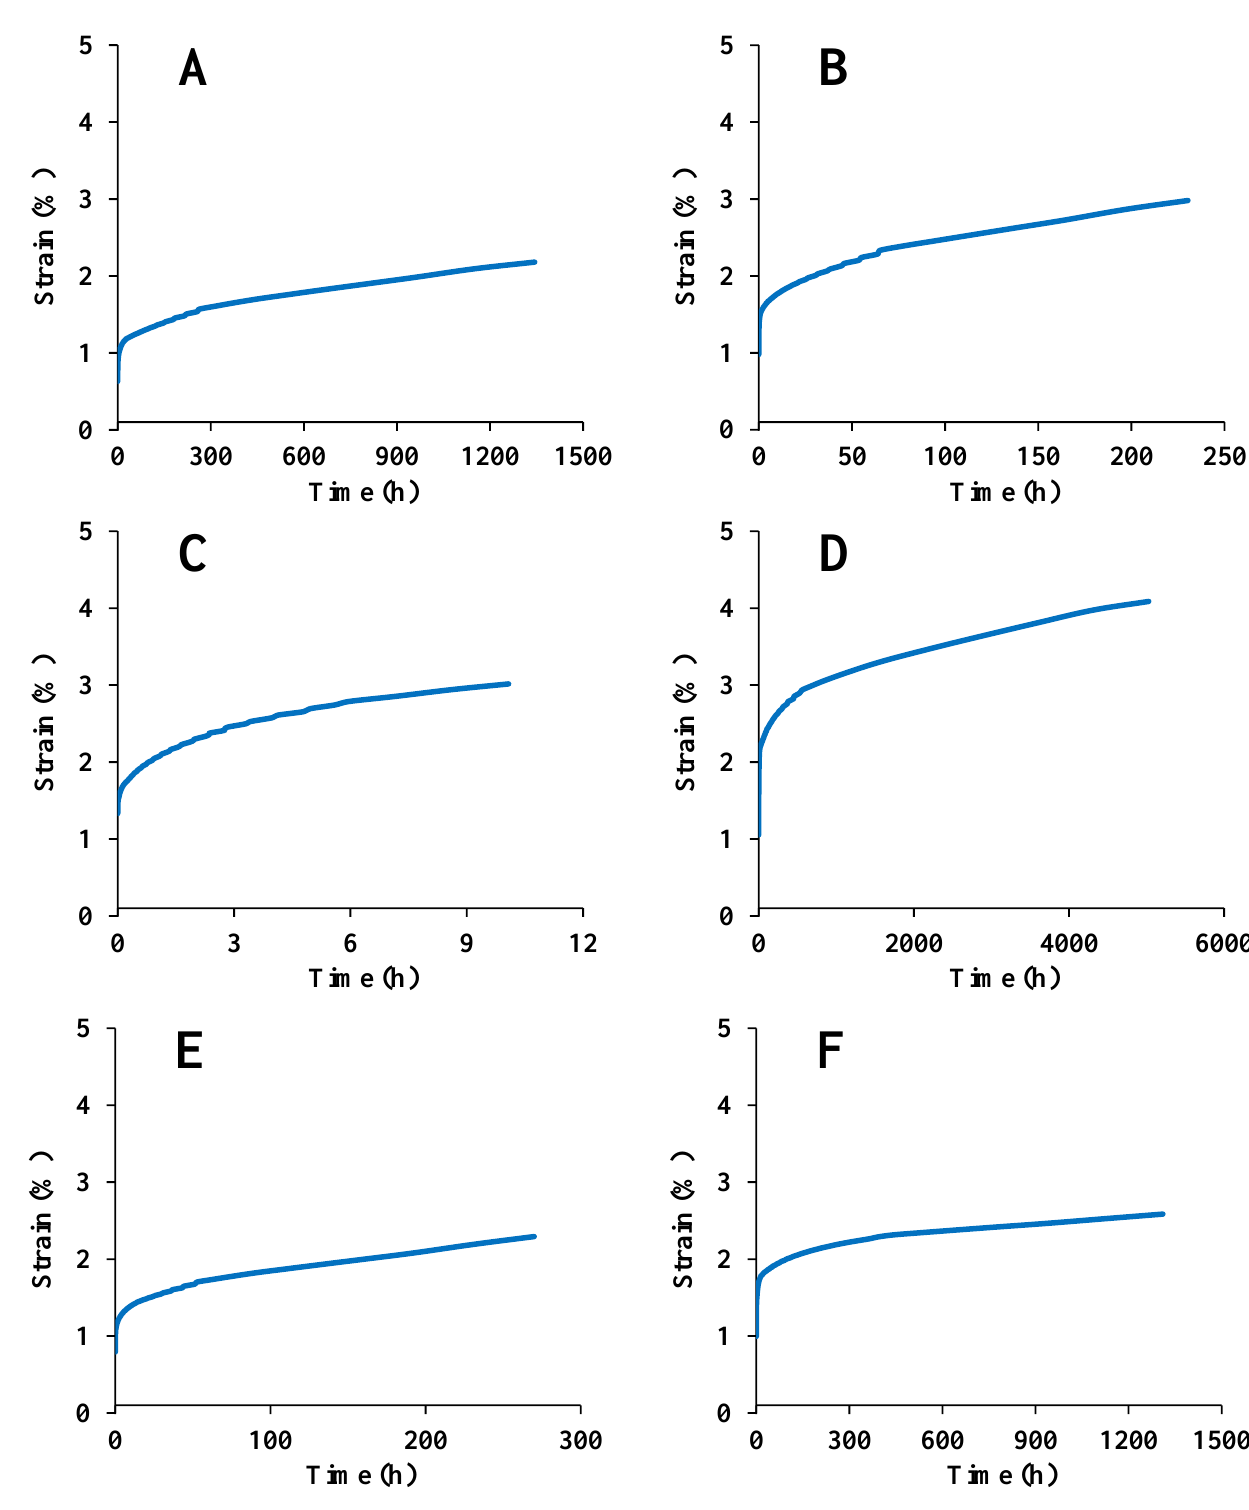
Figure 8. TTS predicted creep for maize kernels dried under different conditions: ( A ) ND; ( B ) HVD 35 °C; ( C ) HVD 45 °C; ( D ) HVD 55 °C; ( E ) HVD 65 °C; ( F ) HVD 75 °C.